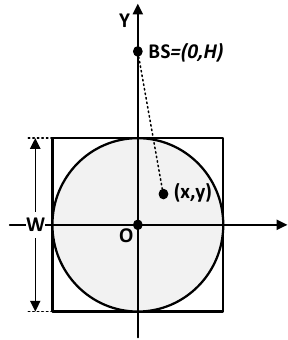
Figure 3. The diagram for calculating (cid:1856) (cid:3009)(cid:2870)(cid:3003) , which is the average distance between CH nodes and BS. For the convenience of calculations, we assume that the CH lies inside the grey circle in Figure